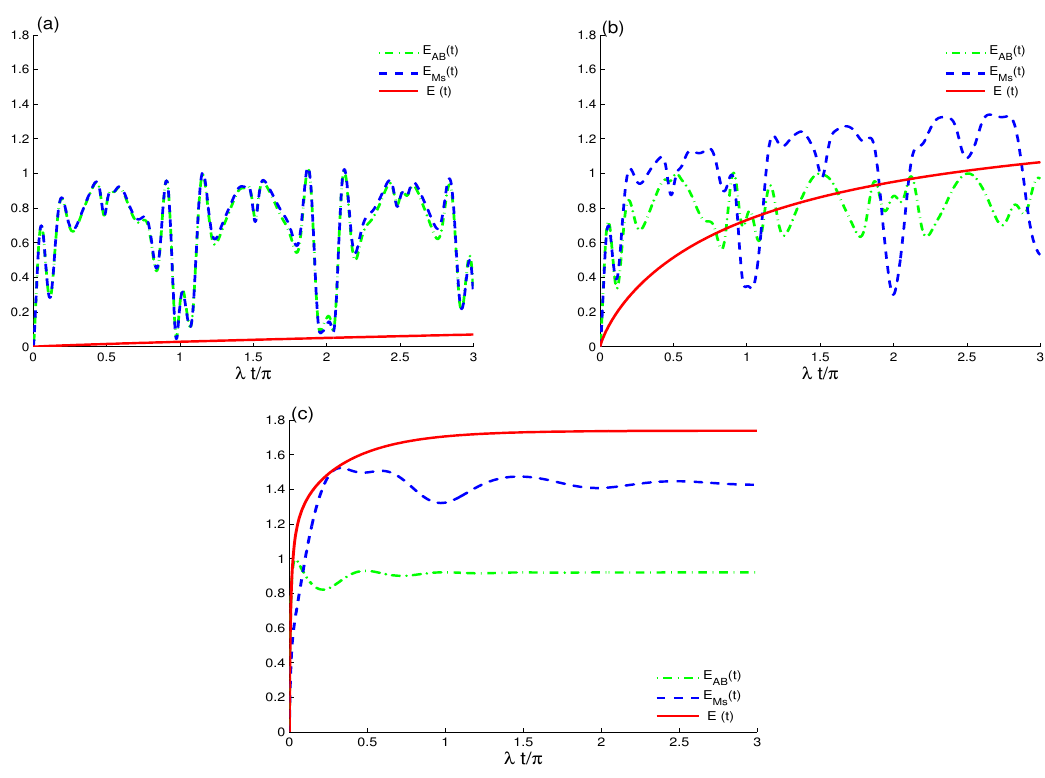
Figure 3. The quantifiers E ( t ) (solid curves), E AB ( t ) (dash-dot curves), and E Ms ( t ) (dash curves) for α = 5 and J / λ = 0. With different decoherence values: γ / λ = 0.00001 in ( a ), γ / λ = 0.001 in ( b ), γ / λ = 0.1 in ( c